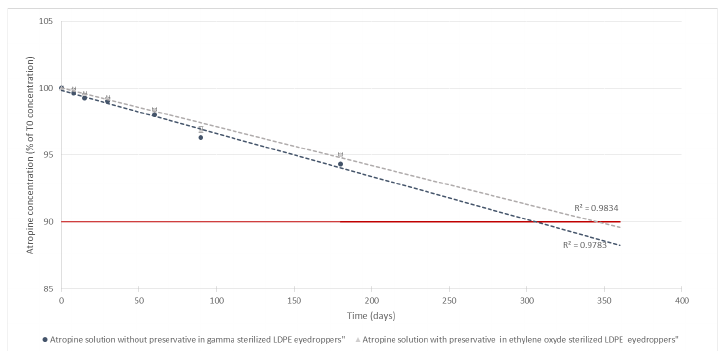
Figure 4. Evolution of atropine concentration over time ( n = 5, mean ± 95% confidence interval): the grey curve is the atropine solution with preservatives conditioned in low-density polyethylene (LDPE) CAT ® eyedroppers. The blue curve is the atropine solution without preservatives conditioned in LDPE NOVELIA ® eyedroppers. The red line is 90% of the initial concentration. The dotted lines are the calculated linear regression of the evolution of atropine concentrations. Pharmaceutics 2020 , 12 , x FOR PEER REVIEW